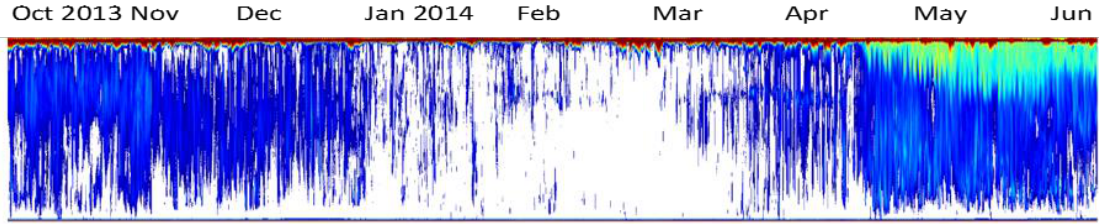
Figure 7. Seasonal dynamics of biomass in the water column (vertical axis) as observed in the acoustic records from October 2013 to June 2014 (horizontal time axis). The acoustic system also observes with seconds and cm resolution giving access to, for example, individual fish behavior information by depth (vertical axis). High biomass densities are defined by red color and biomass is gradually decreasing when the color goes towards blue. No biomass is recorded when the echogram is white (processed from LoVe data by E. Johnsen, Institute of Marine Research, Bergen).